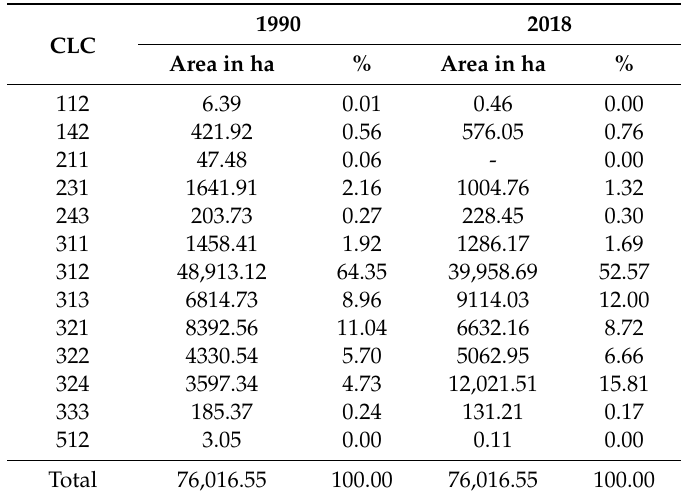
Table 3. Land cover classes of Low Tatras National Park in 1990 and 2018.